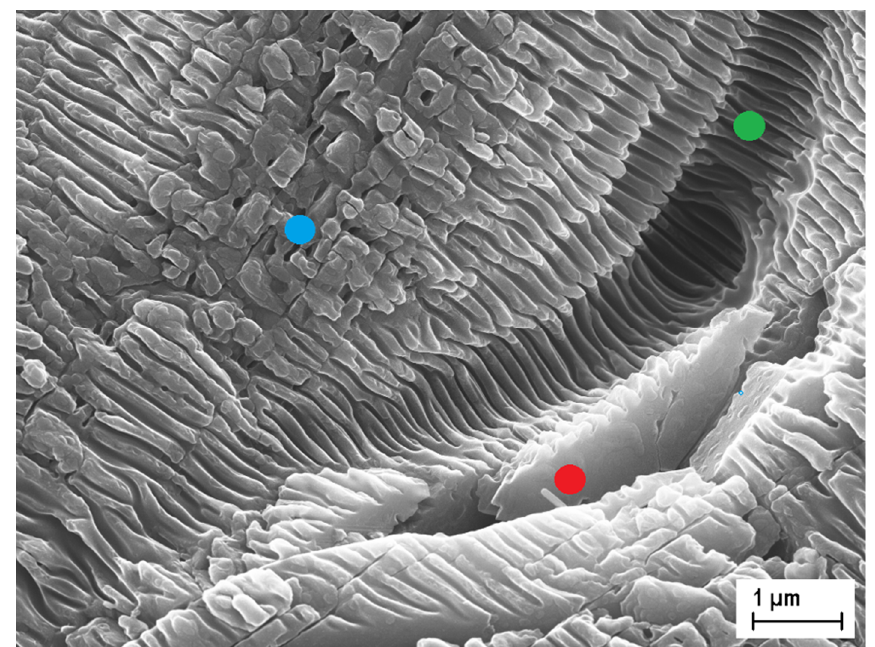
Figure 3. High-magnification detail of the step-terraced surface of sample TM1-air, laser-treated under a compressed air flow. LIPSS are present in most of the treads (green dot), but sometimes they are missing (red dot), or degenerate into irregular nano-squares (blue dot).